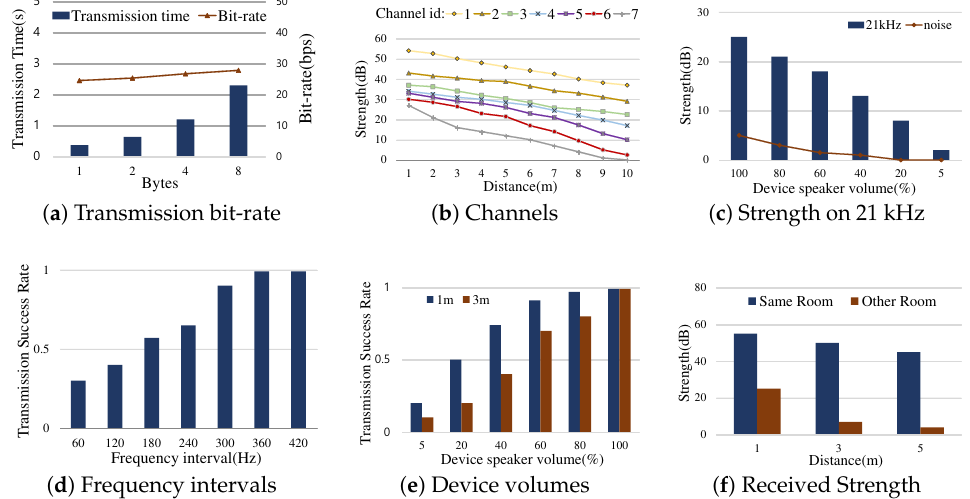
Figure 5. Data transmission experiments using microphones and speakers of consumer devices: these show the test results when MFSK modulation is used for small data transmission through the inaudible frequency range. Each measurement was performed 100 times and denoted by their average